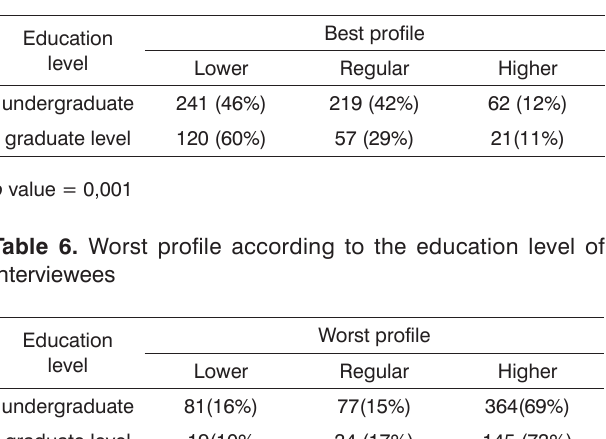
Table 5. Best profile according to the education level of